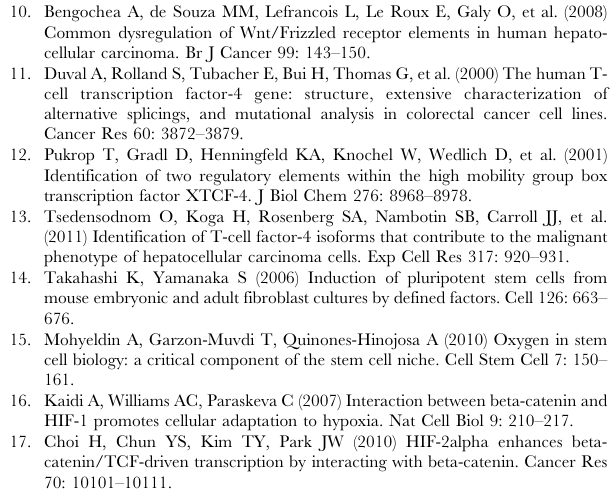
Table S1 Relation between clinicopathological factors and TCF-4A and B, and G and H expression in